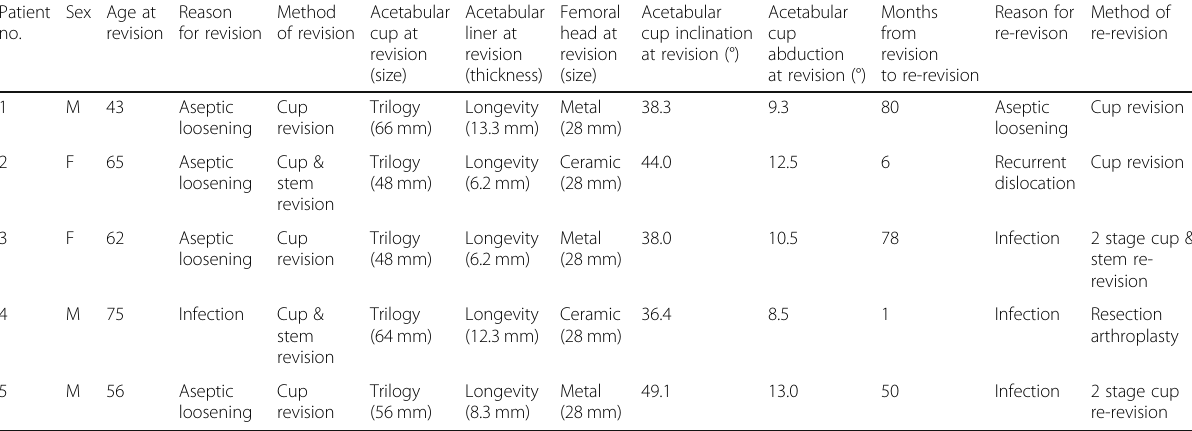
Table 2 Characteristics of patients with re-revision for reasons other than periprosthetic fracture Patient